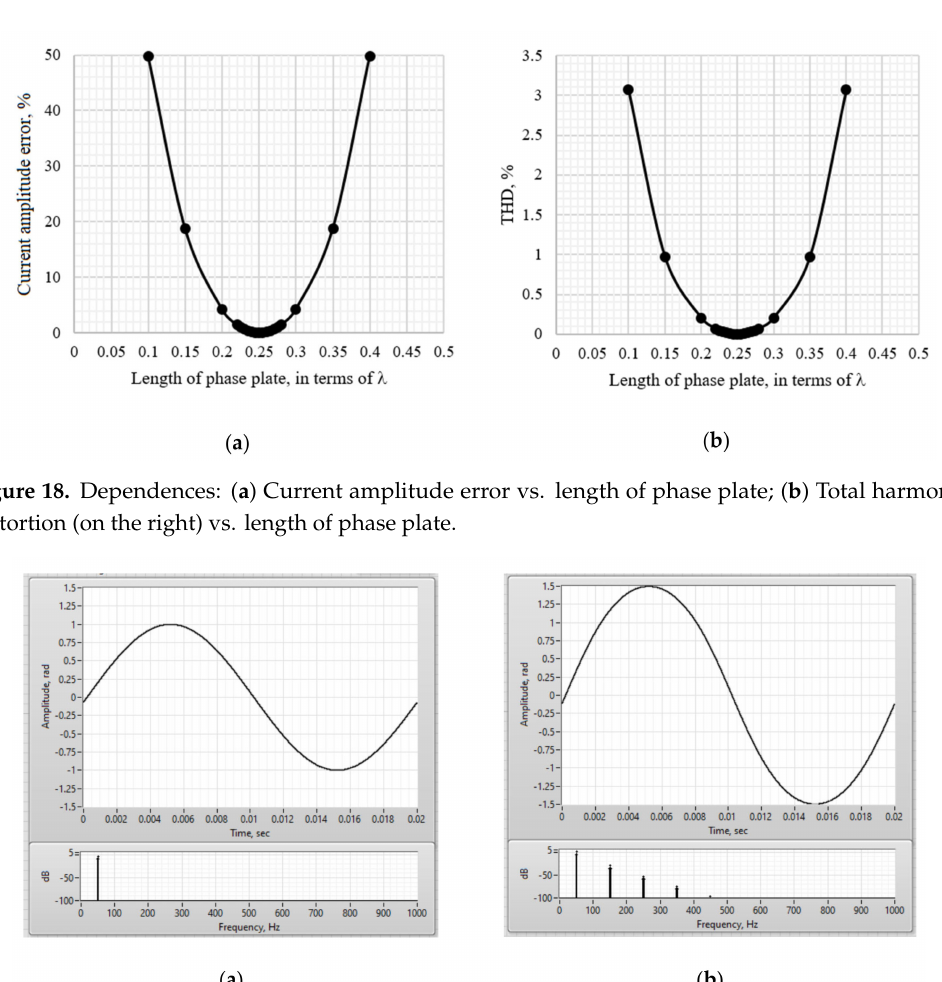
-wave plate; ( b ) Phase 4